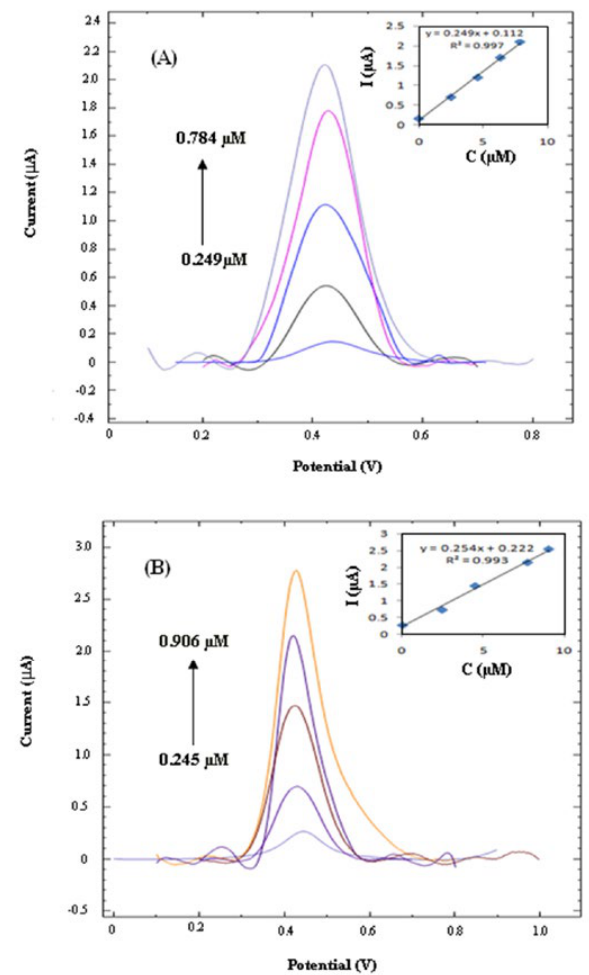
Fig. 10. (A) Chronoamperogram of different concentrations of insulin at the PGE: (a) 0.249 µM, (b) 0.457 µM, (c) 0.633 µM, and (d) 0.784 µM.standard addition method. Inset: related calibration graph. (B) Chronoamperogram of insulin spiked with concentrations (a) 0.245 µM, (b) 0.45 µM, (c) 0.775 µM, and (d) 0.906 µM added to a blood serum sample. Inset: related calibration graph.